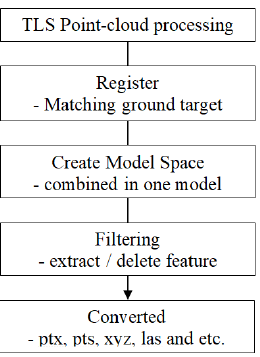
Figure 3. Flows of the processing point-clouds Register point-clouds is also known as point matching (use target on ground as a reference point), is the process of finding a spatial transformation that aligns two or more point set. The purpose of registration is to merge multiple data sets into one model space and readily to filter. Filtering process is to extract feature from raw point-clouds dataset. After filtering is completed, point-clouds data will be converted into